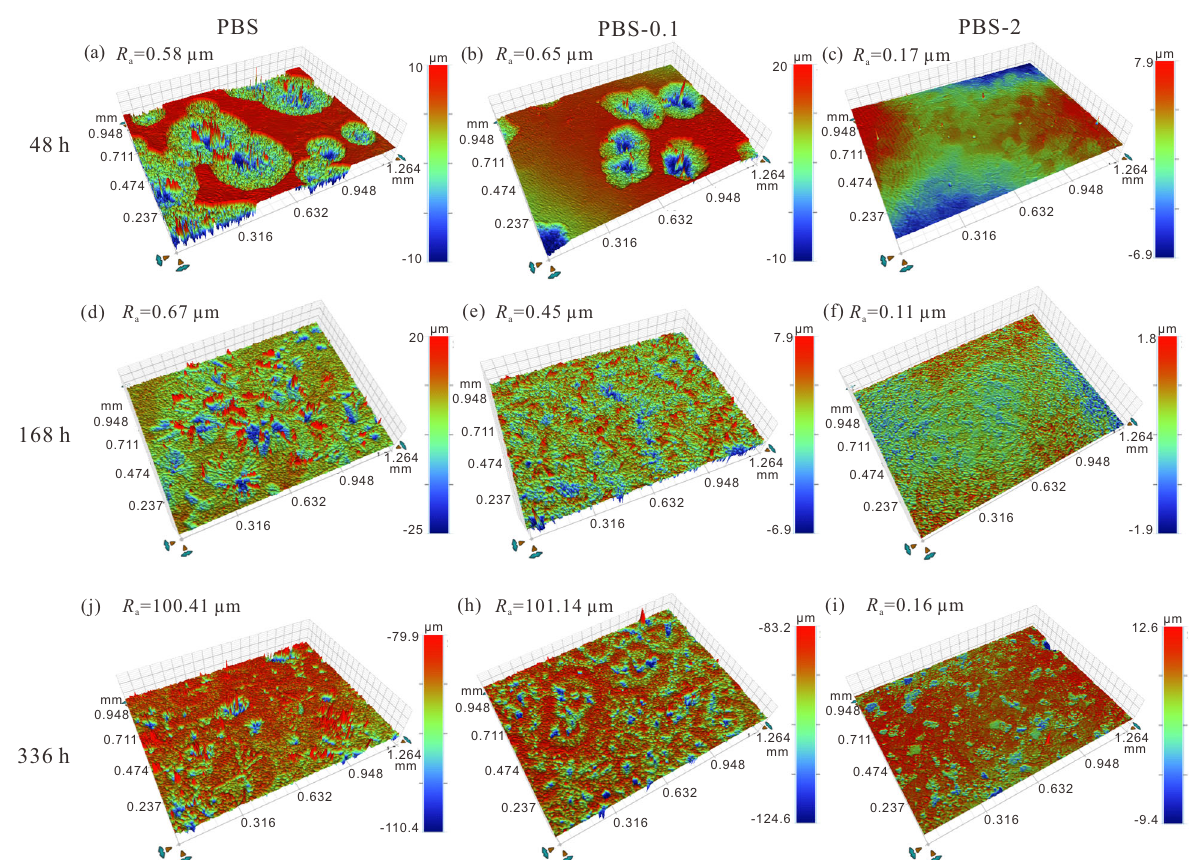
Fig. 4 3D pro fi le images of the pure Zn after immersion in a, d, g PBS-0, b, e, h PBS-0.1 and c, f, i PBS-2 for a – c 48 h, d – f 168 h, and g – i 336